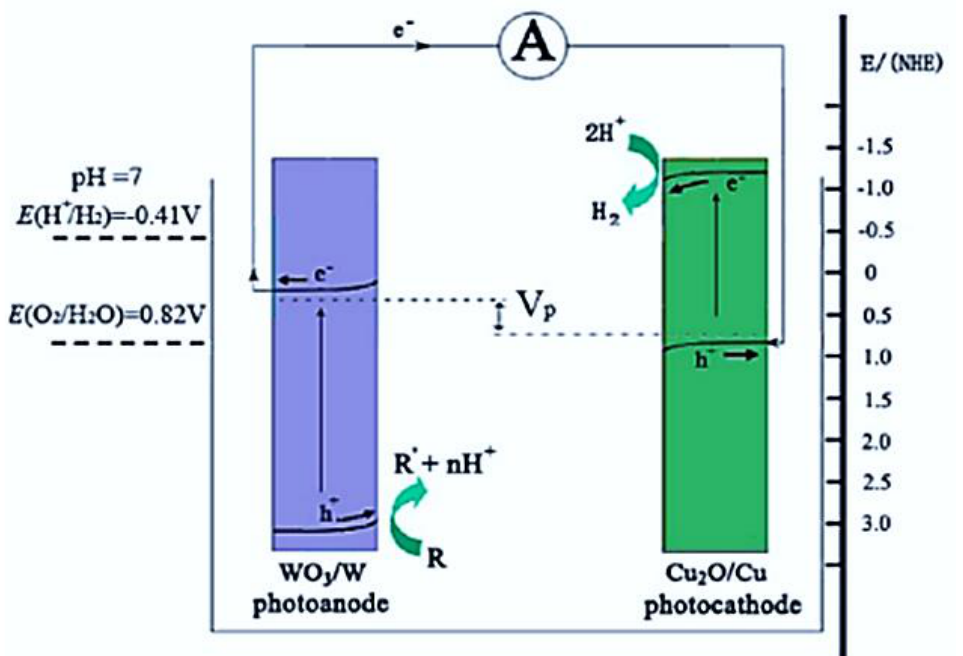
Figure 2. Energy level of diagram of the PFC cell (WO 3 /W − Cu 2 O/Cu) for organic compounds degradation and electricity generation (Vp, photovoltage). Adapted with permission from Ref. [67]. Copyright 2012, American Chemical Society.